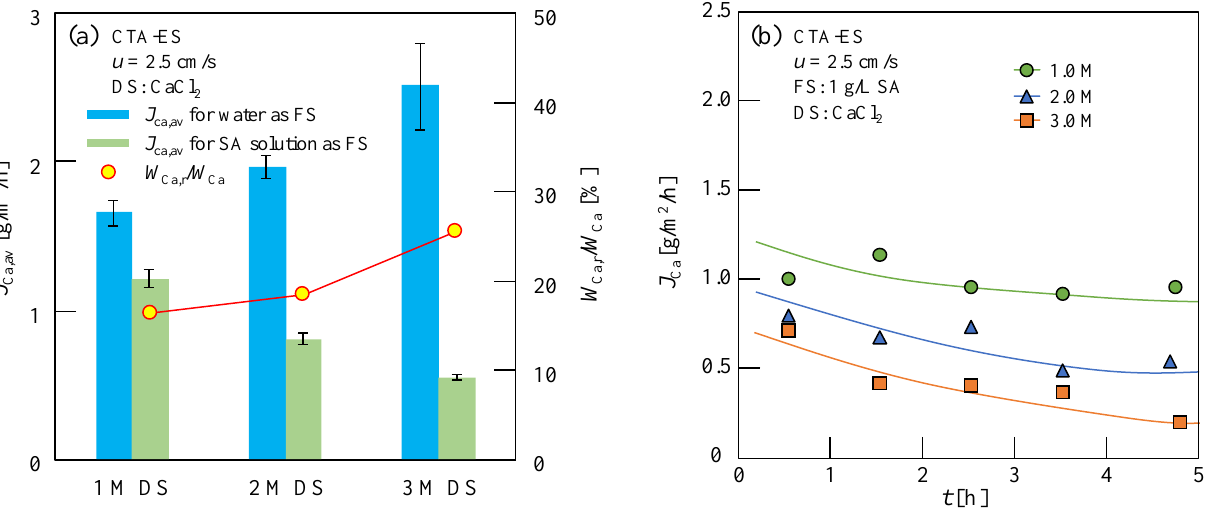
Figure 2. ( a ) Average reverse solute flux (RSF) of Ca 2+ ( J Ca,av ) for ultrapure water and sodium alginate (SA) solution as feed solution (FS) and percentage of Ca 2+ content in Ca-Alg recovery production (CARP) formed on the forward osmosis (FO) membrane ( W Ca,r ) to total Ca 2+ content ( W Ca ) in the FS containing Ca 2+ in the CARP, W Ca,r / W Ca , for SA solution as the FS in FO with various CaCl 2 solutions as the draw solution (DS); ( b ) RSF of Ca 2+ without considering Ca 2+ in the CARP ( J Ca ) with the progress of FO. Here, 1.0 g/L SA solution and 1–3 M CaCl 2 solution were used as the FS and DS, respectively; for the flow rates of 2.5 cm/s, u along opposite directions on both sides of the membrane was used; CTA-ES, cellulose triacetate with embedded polyester screen support.